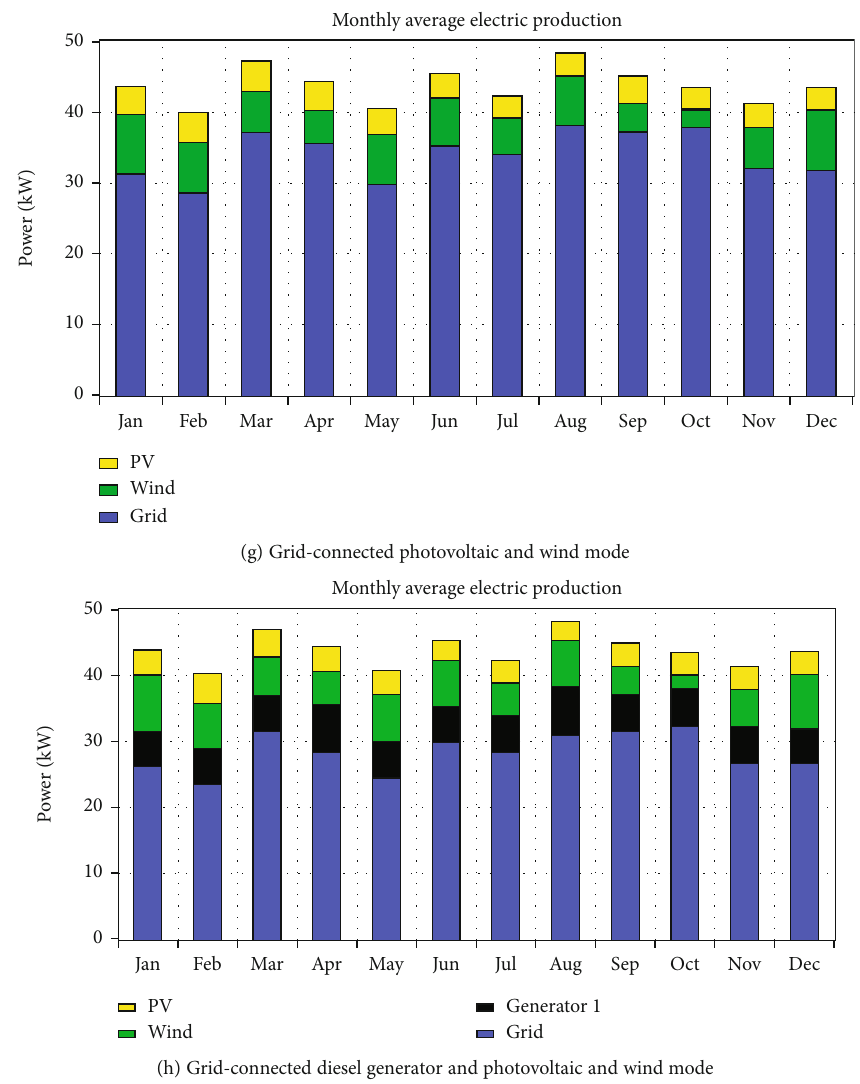
Figure 7: Monthly average power production in eight workable HRES con fi